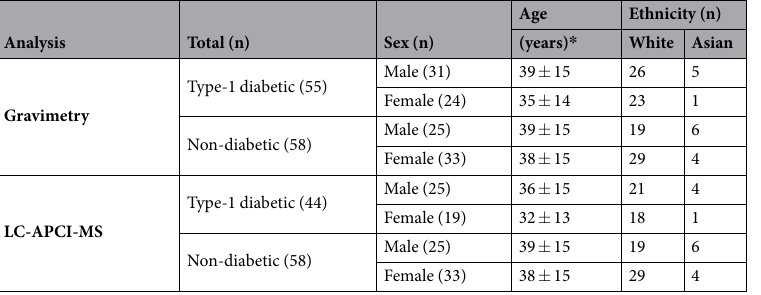
Table 4. Summary of residual skin surface component analysis, performed using gravimetry and liquid chromatography with atmospheric pressure chemical ionization mass spectrometry, in relation to volunteer details. * Data given as mean ± standard